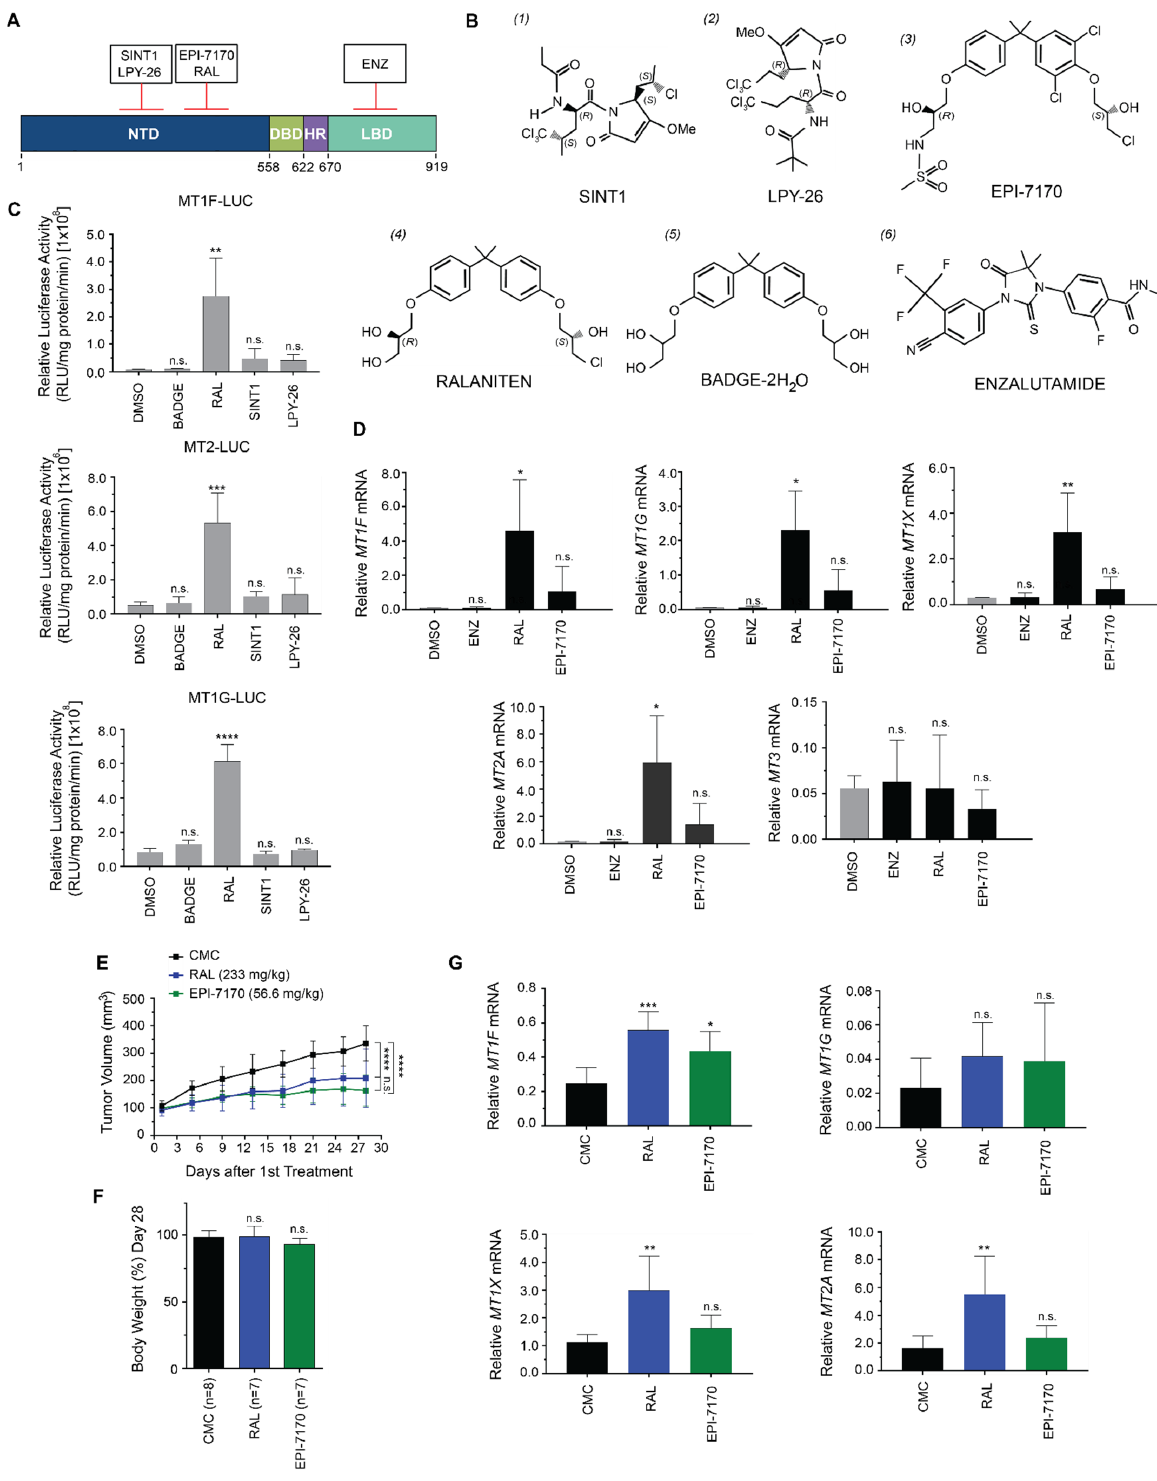
Figure 2. Ralaniten-induced expression of metallothionein in vitro and in vivo. ( A ) Illustration depicting the various compounds tested with respect to which region they bind on AR. ( B ) Chemical structure of each compound. BADGE-2H 2 O does not bind AR and has no inhibitory effect on AR transcriptional activity. ( C ) LNCaP cells transfected with the various MT1/2-luciferase reporters and treated with DMSO, BADGE-2H 2 O (35 µ M), ralaniten (35 µ M), SINT1 (35 µ M), or LPY-26 (35 µ M) for 24 h. Data presented as mean ± SD and analyzed by one-way ANOVA with Dunnett’s test